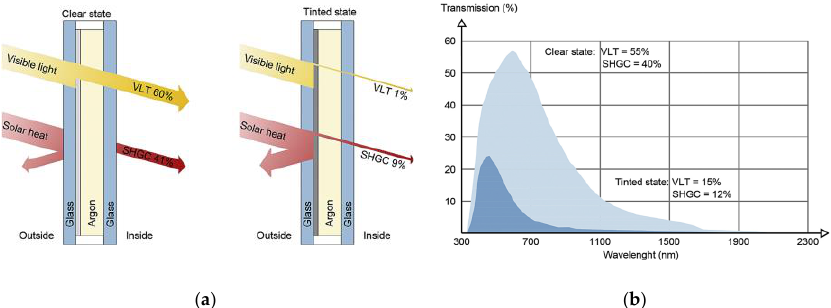
Figure 4. Transmittance modulation of an EC device, between the colored and bleached conditions. The insert reports the cross-section of the multi-layered device measured. Reprinted from